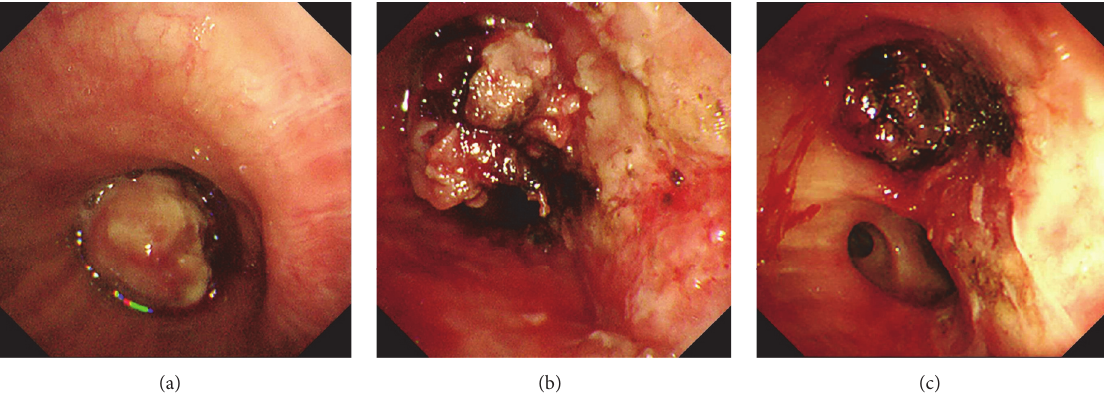
Figure 3: (a) A polypoid tumor completely occluded the lumen of the left main bronchus. (b) After the first electrocautery procedure, the left inferior lobar bronchus could be partially visualized. (c) After the second electrocautery procedure performed 4 days after the first one, the left inferior lobar bronchus could be fully